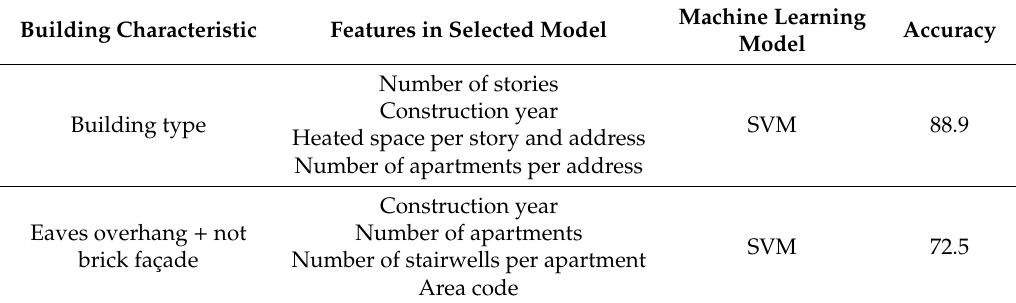
Table 8. The chosen prediction model and its accuracy for each of the predicted building